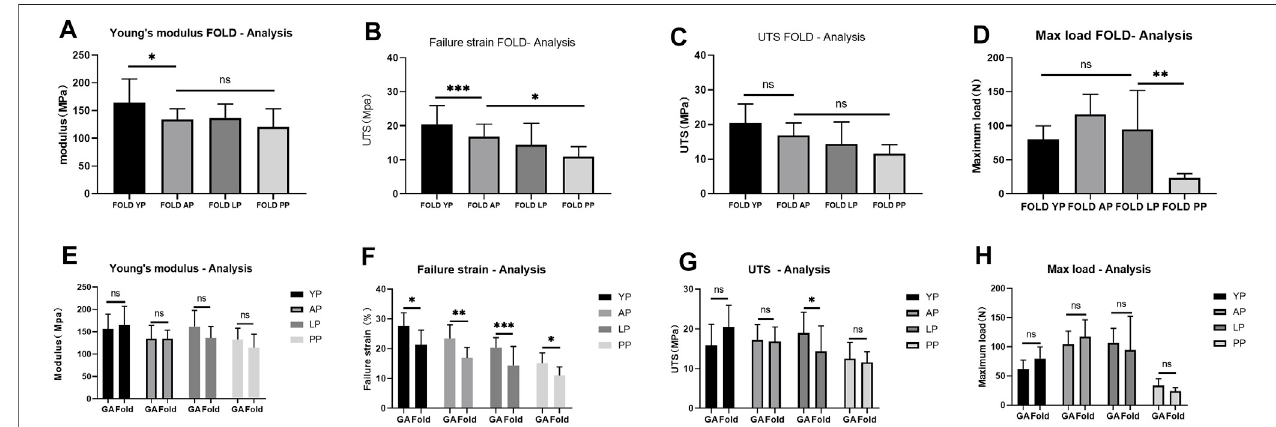
FIGURE 10 | Mechanical performance of Fold-yak pericardium, Fold-Australian bovine pericardium, Fold-local bovine pericardium, and Fold-porcine pericardium And compare the mechanical properties before and after folding. (A) , Young ’ s modulus; (B) , Failure strain; (C) , The ultimate tensile strength (UTS); (D) , Max load. (E) , ComparisonofYoung ’ smodulusbeforeandafterfolding. (F) ,ComparisonofFailurestrainbeforeandafterfolding. (G) ,ComparisonofUTSbeforeandafterfolding. (H) , Comparison of Max load before and after folding. we use two-way ANOVA for statistical analysis ( n (cid:2) 10; * p < 0.05; ** p < 0.01;*** p < 0.001; ns represents no signi fi cant difference).